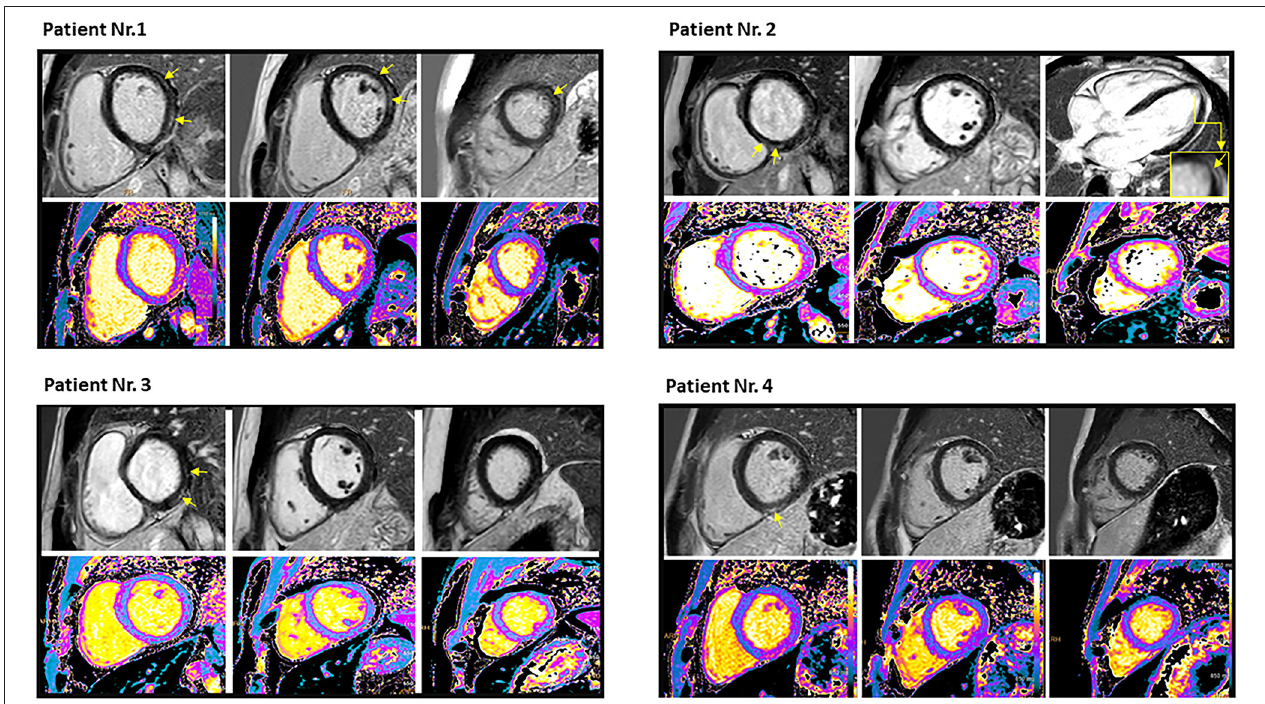
FIGURE 1 | Cardiac magnetic resonance imaging of the four patients who had myocarditis following the third dose of mRNA COVID-19 vaccination demonstrated late gadolinium enhancement (yellow arrows) and T1 mapping (lower row). Patient no. 1: Mid wall late gadolinium enhancement involving 9% of the myocardium with corresponding myocardial injury in native T1 mapping imaging in antero- and infero-lateral segments of basal and mid ventricular short-axis view, as well as in the lateral segment of apical short-axis view. Native T1 value was 1,135ms, and T2 value was 69.2ms. Peak troponin was 240ng/L, and scan delay (from COVID-19 vaccine) was 8 days. Patient no. 2: Mid wall late gadolinium enhancement involving 1% of the myocardium with corresponding myocardial injury in native T1 mapping imaging in the lateral segment of apical and in the septal segment of the basal short-axis view. Native T1 value was 1,077ms, and T2 value was 57.5ms. Peak troponin was 80ng/L, and scan delay (from COVID-19 vaccine) was 40 days. Patient no. 3: Epicardial late gadolinium enhancement involving 3% of the myocardium with corresponding myocardial injury in native T1 mapping imaging in the inferior and inferolateral segments of the basal short-axis view. Native T1 value was 1,155ms, and T2 value was 58.1ms. Peak troponin T was 4,967ng/L, and scan delay (from COVID-19 vaccine) was 47 days. Patient no. 4: Mid wall late gadolinium enhancement involving 1% of the myocardium with corresponding myocardial injury in native T1 mapping imaging in inferior segments of the basal and mid-ventricular short axis view, as well as in the lateral segment of the apical short axis view. Native T1 value was 1,041ms, and T2 value was 57.4ms. Peak troponin T was79ng/L, and scan delay (from COVID-19 vaccine) was 42 days. Reference (normal) values: T1: 950–1,060ms, T2: < 57ms, and troponin T <